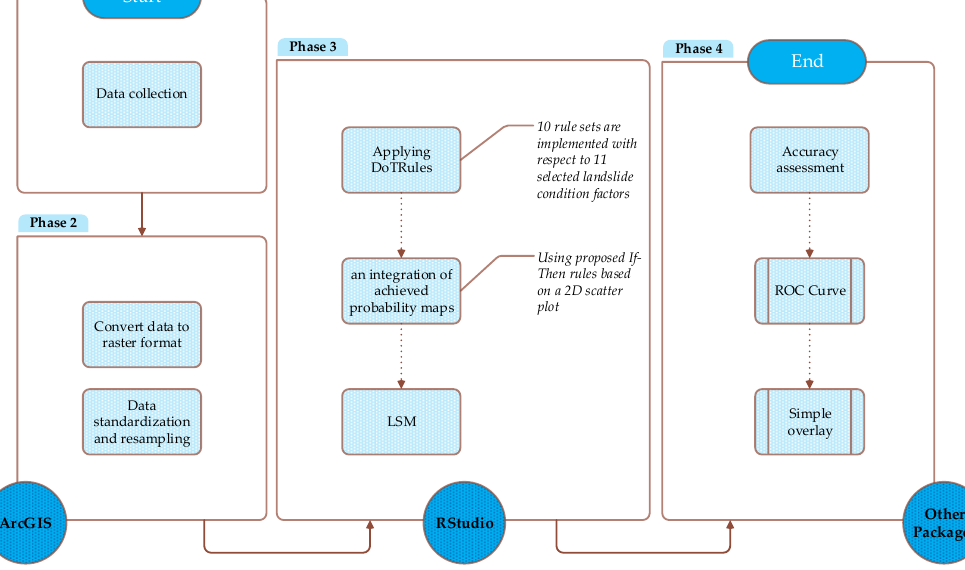
Figure 4. Schematic representation of the four-step methodology implementation.